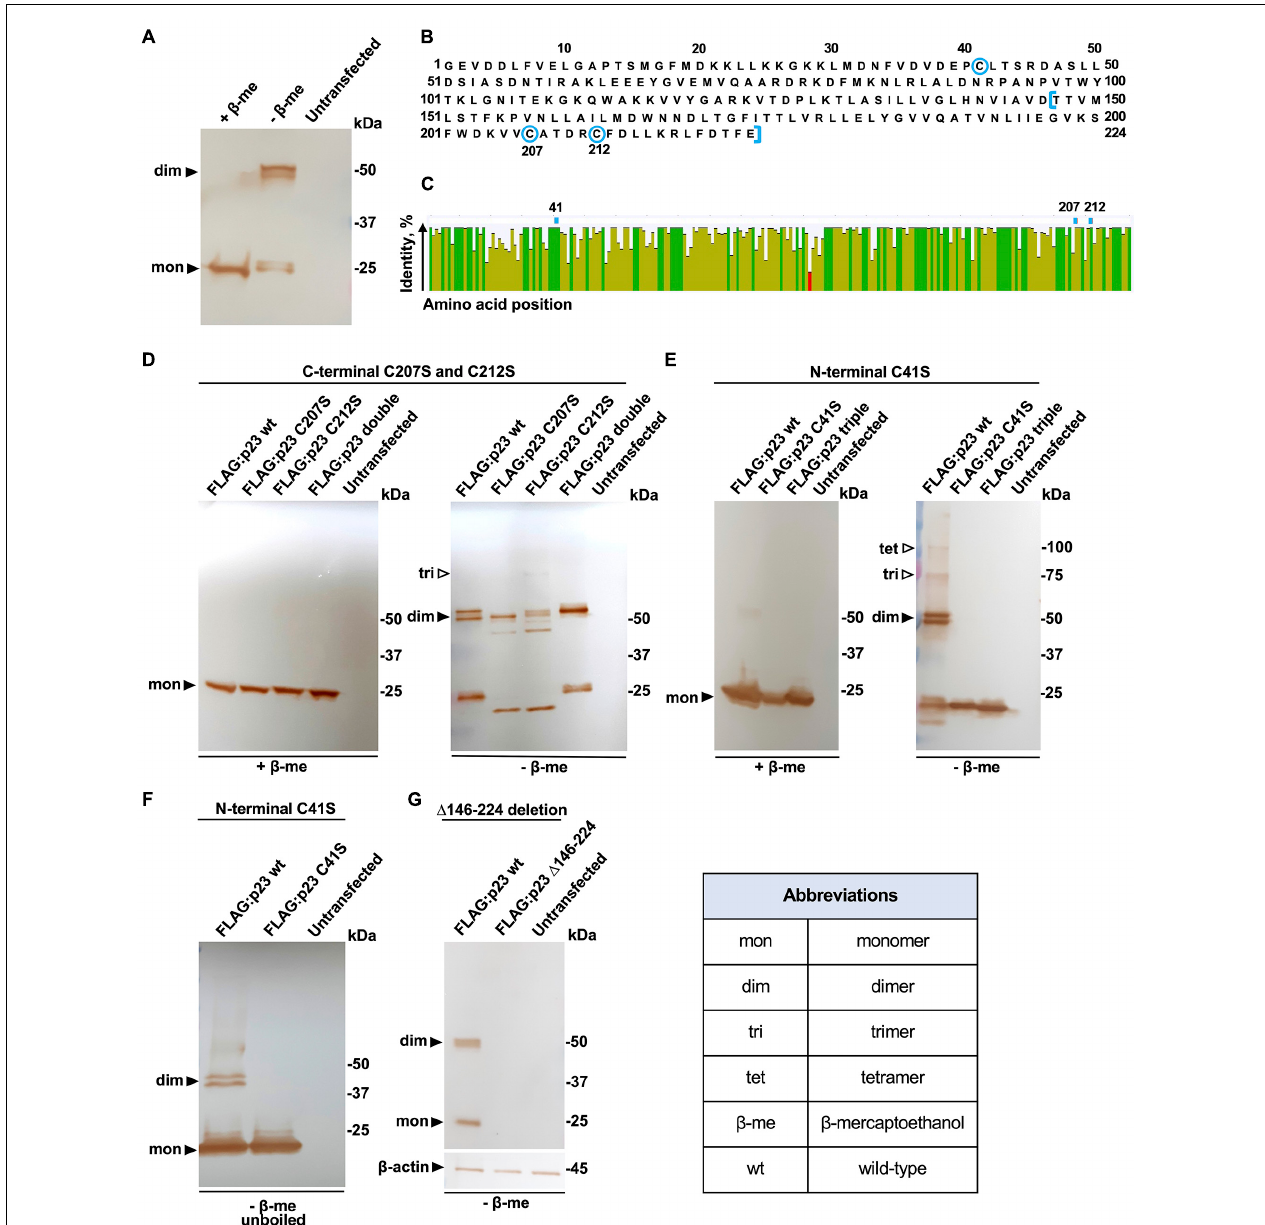
FIGURE 2 | Dimerization of p23 depends on disulfide bond formation. (A) Recombinant FLAG-tagged p23 (wt, wild-type) expressed in transiently transfected RK-13 cells was eluted from an anti-FLAG resin with reducing or non-reducing Laemmli buffer containing β -mercaptoethanol (+ β -me) or without β -mercaptoethanol (– β -me), respectively. Affinity purified p23 was separated by SDS-PAGE and analyzed by Western blotting using anti-FLAG antibodies; bands corresponding to monomeric p23 and dimeric forms can be observed. Untransfected RK-13 cell lysate was subject to immunoprecipitation as a negative control. The position of molecular mass standards is shown at the right. (B) RHDV/GI.1 p23 (NC_001543.1) protein sequence; the three cysteine residues at positions 41, 207, and 212 are highlighted using blue circles; and amino acids truncated in variant FLAG:p23 (cid:49) 146–224 are indicated using blue square brackets. (C) A consensus sequence and identity plot were generated using 567 lagovirus p23 sequences; the positions of the cysteine residues at position 41, 207, and 212 are indicated above the plot. The percentage identity at each amino acid position is indicated by column height and color (green means completely conserved, olive means less than complete identity, and red refers to a low identity). (D) Variants with C-terminal cysteine substitutions. Dimer formation of p23 wild-type (wt) and variants with cysteine-to-serine substitutions at positions 207 (C207S) or 212 (C212S) or both, ‘double’ was not affected under non-reducing conditions; the possible formation of a trimer is suggested by a weak band. (E) Dimers did not form between p23 variants with a cysteine-to-serine substitution at position 41 or in variants that had all cysteines substituted to serine (‘triple’); higher-order oligomers, trimers, and tetramers are seen in non-reducing conditions. (F) Unboiled samples were analyzed in a gel that did not contain SDS. Under these conditions, the C41S variant did not form dimers and both the wt protein and the C41S variant failed to form higher-order oligomers. In panel D, 10- µ l samples were loaded per lane, and in E and F, 20- µ l samples were loaded per lane (to enhance the detection of higher- order oligomers). (G) The truncated p23 (cid:49) 146–224 variant without transmembrane helices was not detected in either monomeric or dimeric form.